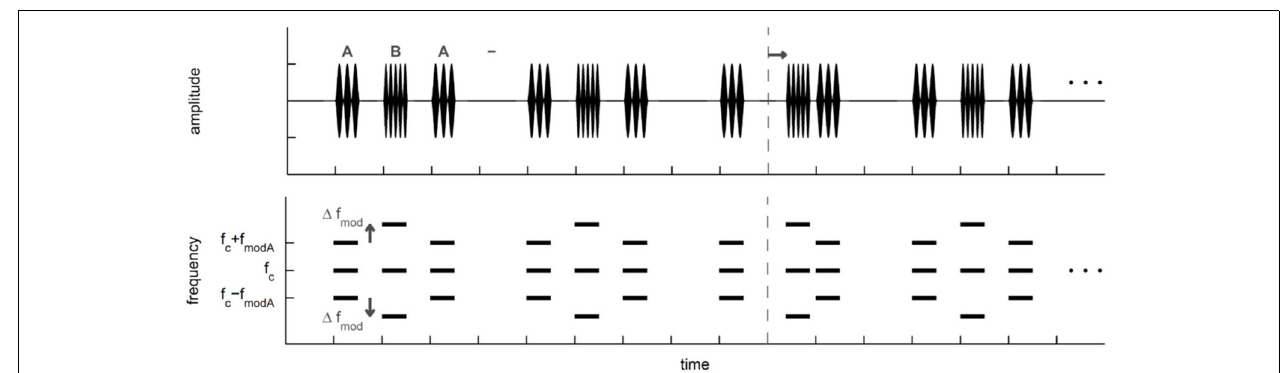
FIGURE 1 | Schematic view of the ABA-triplets presented in the objective task that relied on the detection of a time shifted B signal. In the third ABA- triplet a black arrow indicates the shift of the B signal, whereas the dashed line indicates the former position the un-shifted B signal. Top: Schematic temporal view of the ABA- triplets that were sinusoidally amplitude modulated (SAM) tones. A and B SAM